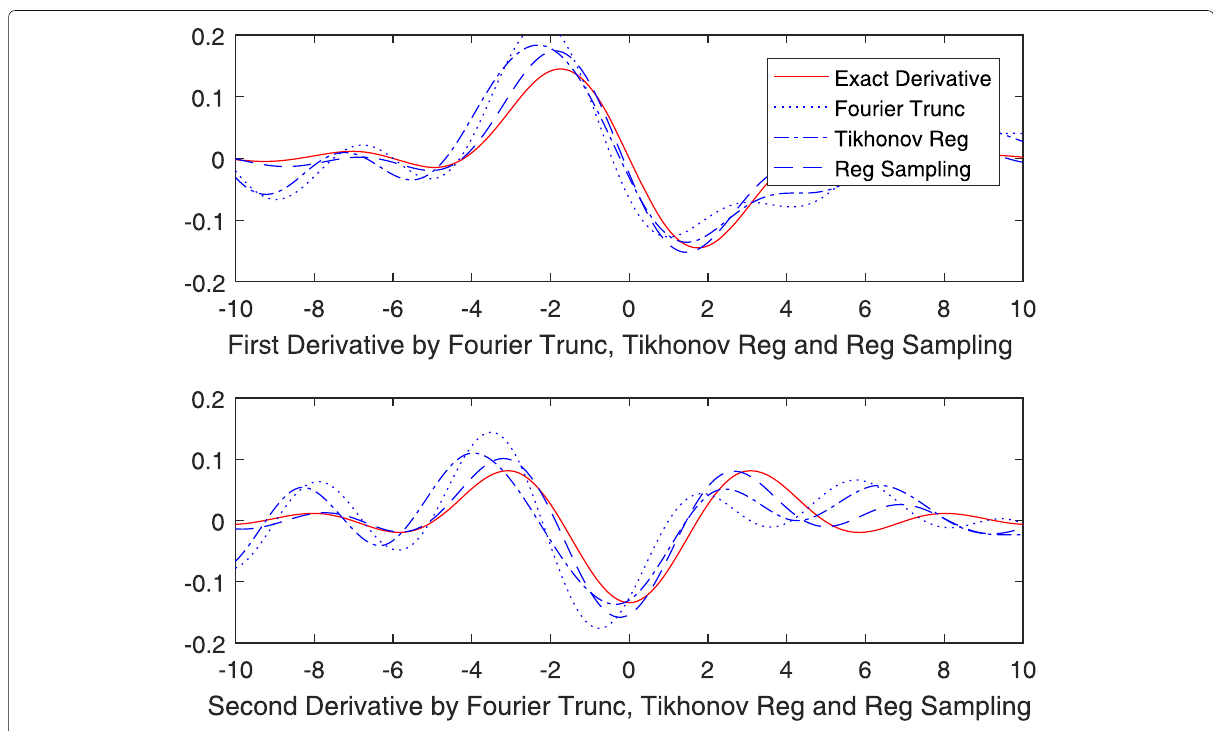
Fig. 5 The simulation results for the uniform noise in Example 3